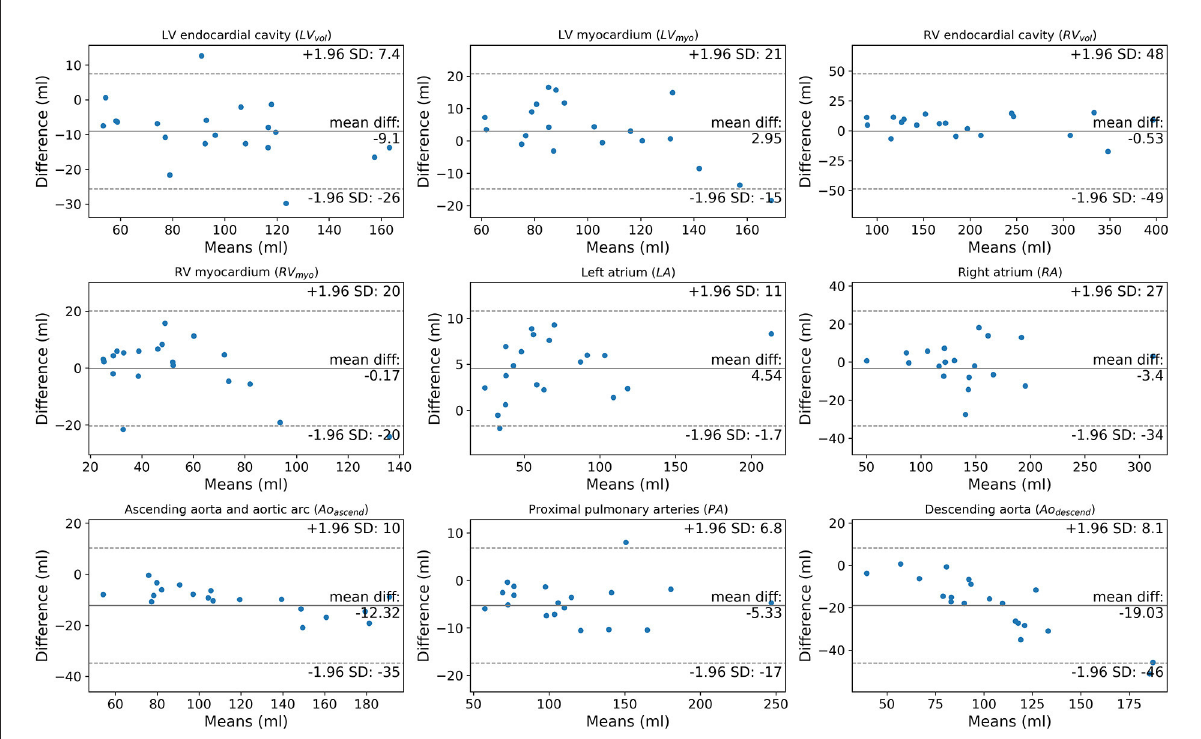
FIGURE7 Bland-Altman plots comparing manually segmented structure volumes by observer 1 (AJS) against DL model 2 in the external cohort ( n = 20).